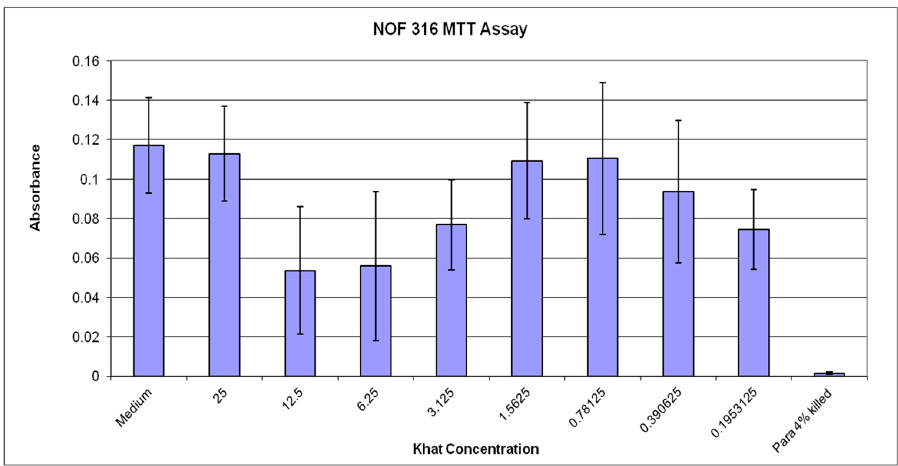
Figure 1. Absorbance from MTT Assay for NOF 316 cells treated with different concentrations of Khat solution (25 mg/mL to 0.195 mg/mL). Medium with only NOF 316 was used as a negative control while 4% paraformaldehyde was used as a positive control showing complete cell death.